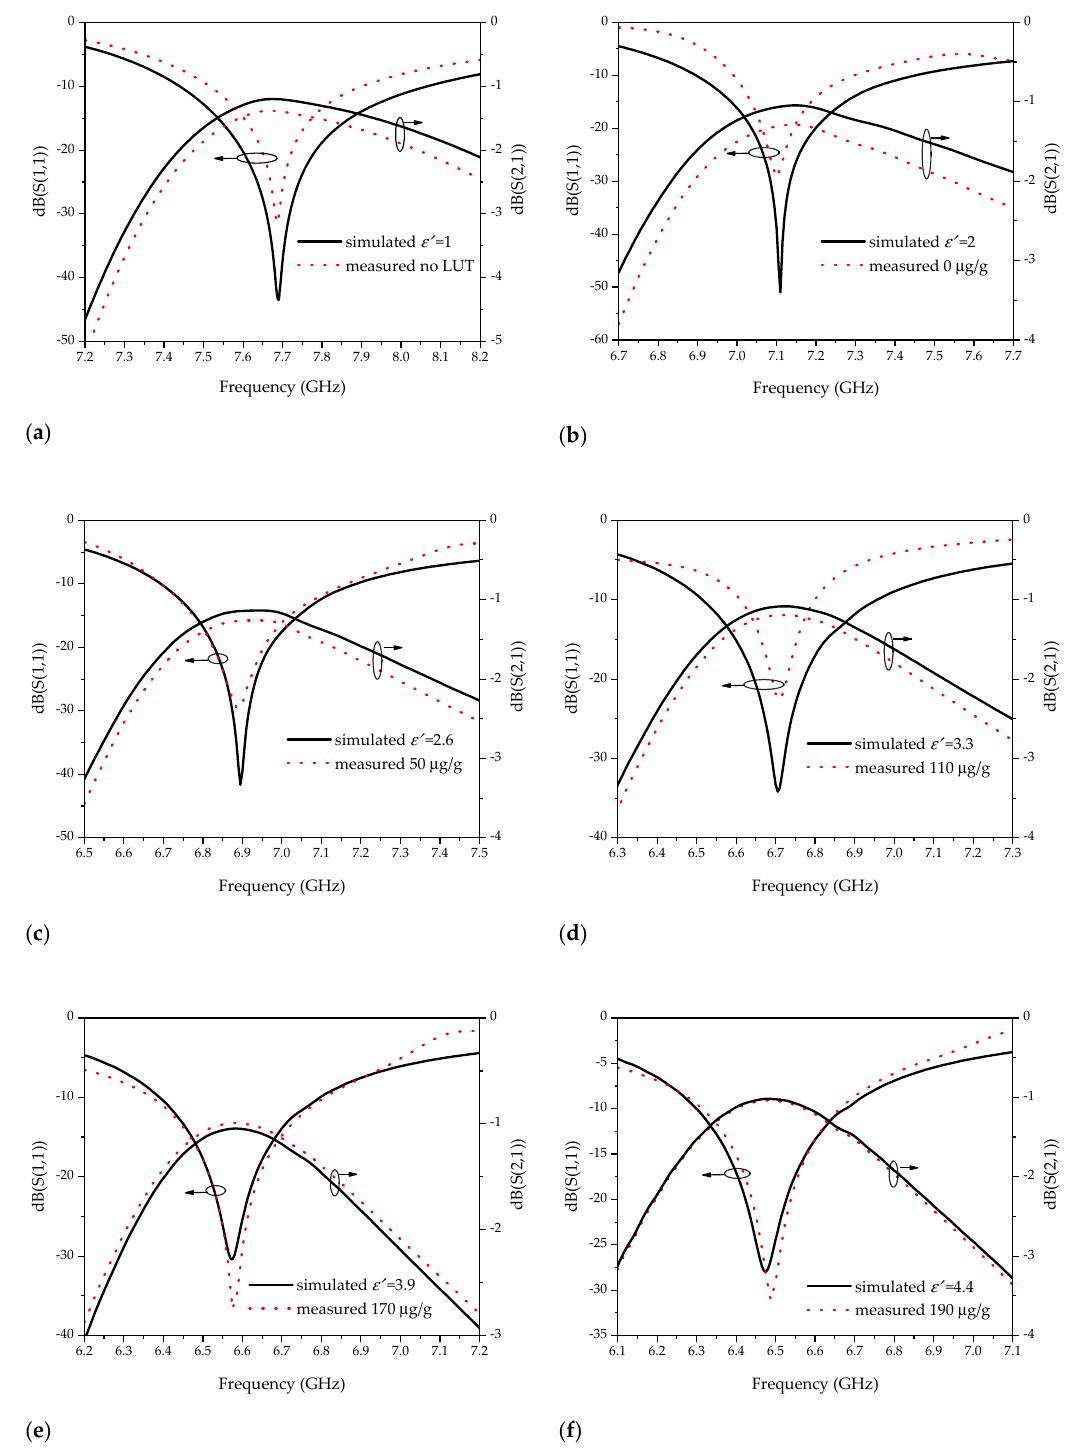
Figure 13. Comparison of the simulation and measured results: ( a ) ε ′ = 1, no ULT; ( b ) ε ′ = 2, content = 0 μ g/g; ( c ) ε ′ = 2.6, content = 50 μ g/g; ( d ) ε ′ = 3.3, content = 110 μ g/g; ( e ) ε ′ = 3.9, content = 170 μ g/g; ( f ) ε ′ = 4.4, content = 190 μ g/g.